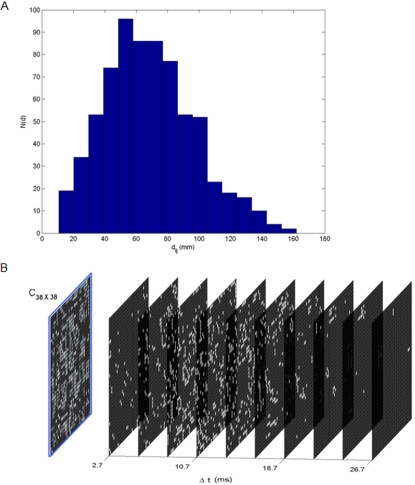
Space time structure of couplings.(A) Distribution of inter-area distances. The time-delays follow identical distribution as we have defined , where v is the propagation velocity. (B) Space-time distribution of time-delays. The blue frame shows the spatial connectivity matrix. The nodes having time delay Δt±1.3 ms are snapped to planes denoting time delay Δt for visual clarification. Here we set propagation velocity v = 6 m/s.